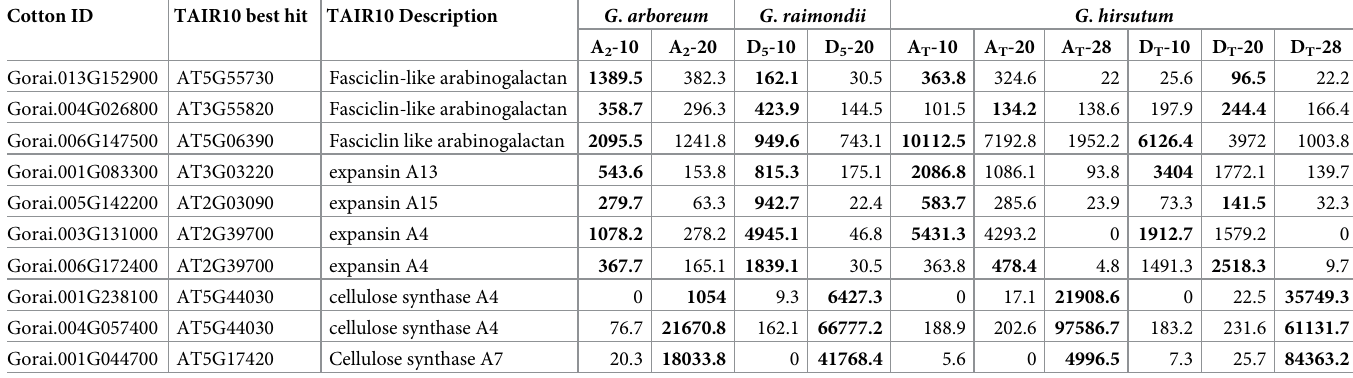
Table 2. Classifications of cotton fiber developmental stages of G . raimondii , G . arboreum , and G . hirsutum . Ten indicator genes are shown for each species according to genome type and at 10, 20, or 28 DPA. The most up-regulated RPKM numbers of each indicator genes in the cotton species were written in bold fonts. Cotton ID TAIR10 best hit TAIR10